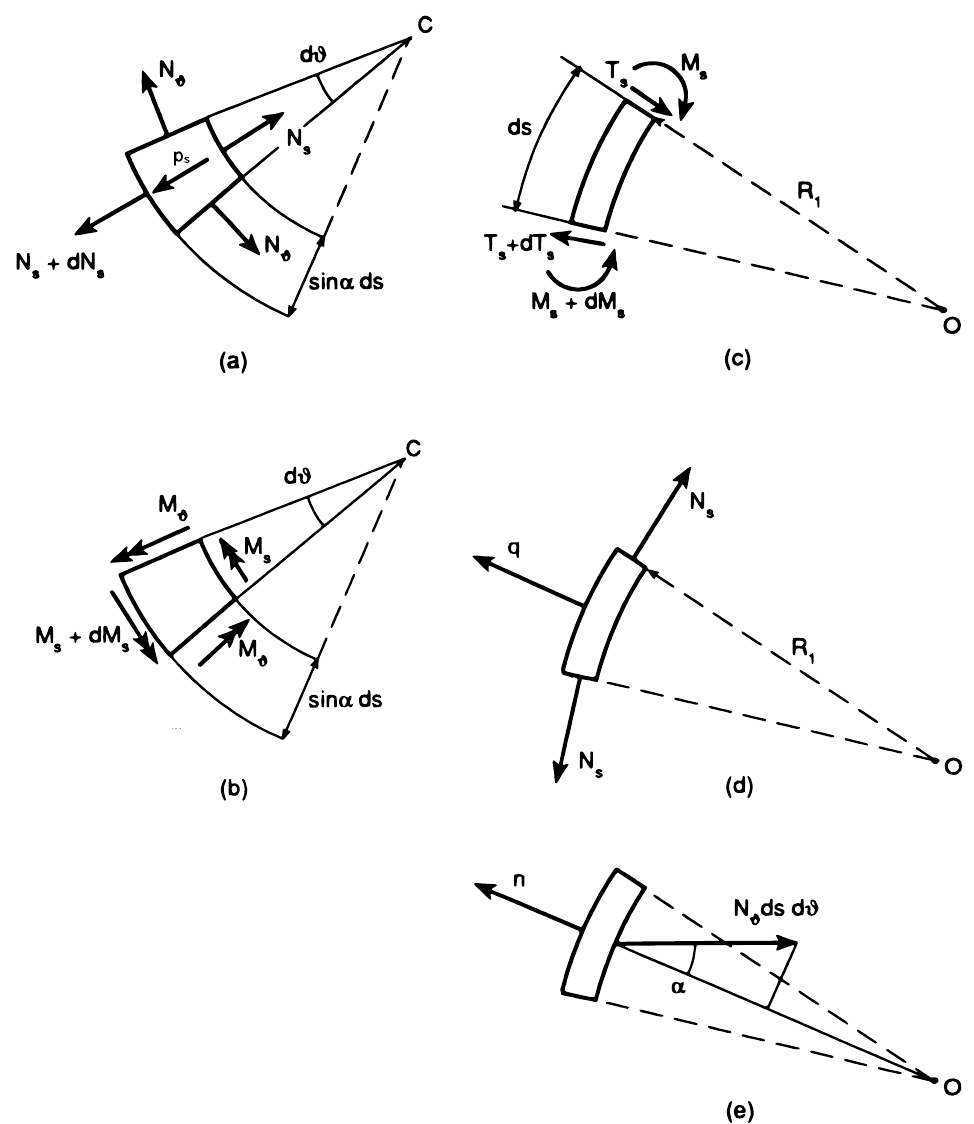
Figure 6: Element isolated from a shell of revolution: (a) equilibrium to translation along the meridian, (b, c) equilibrium to rotation about the parallel, (d, e) equilibrium to translation along the normal to the